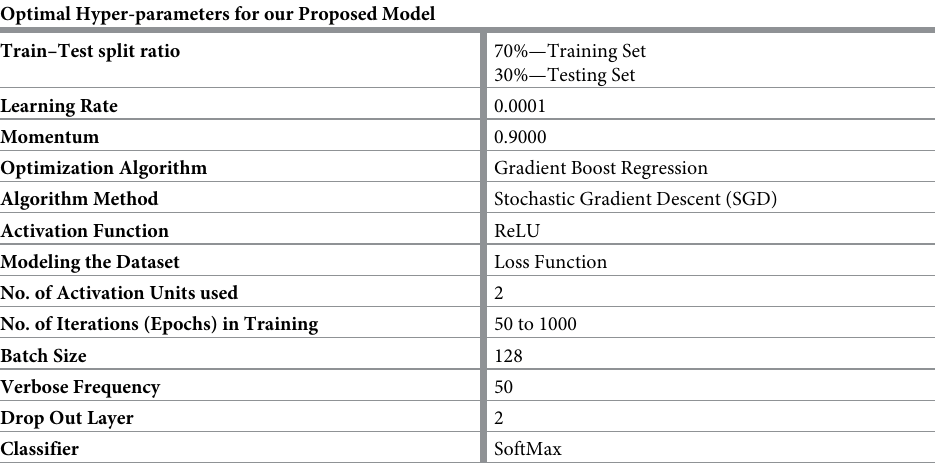
Table 2. Optimal hyper–parameters to train the proposed